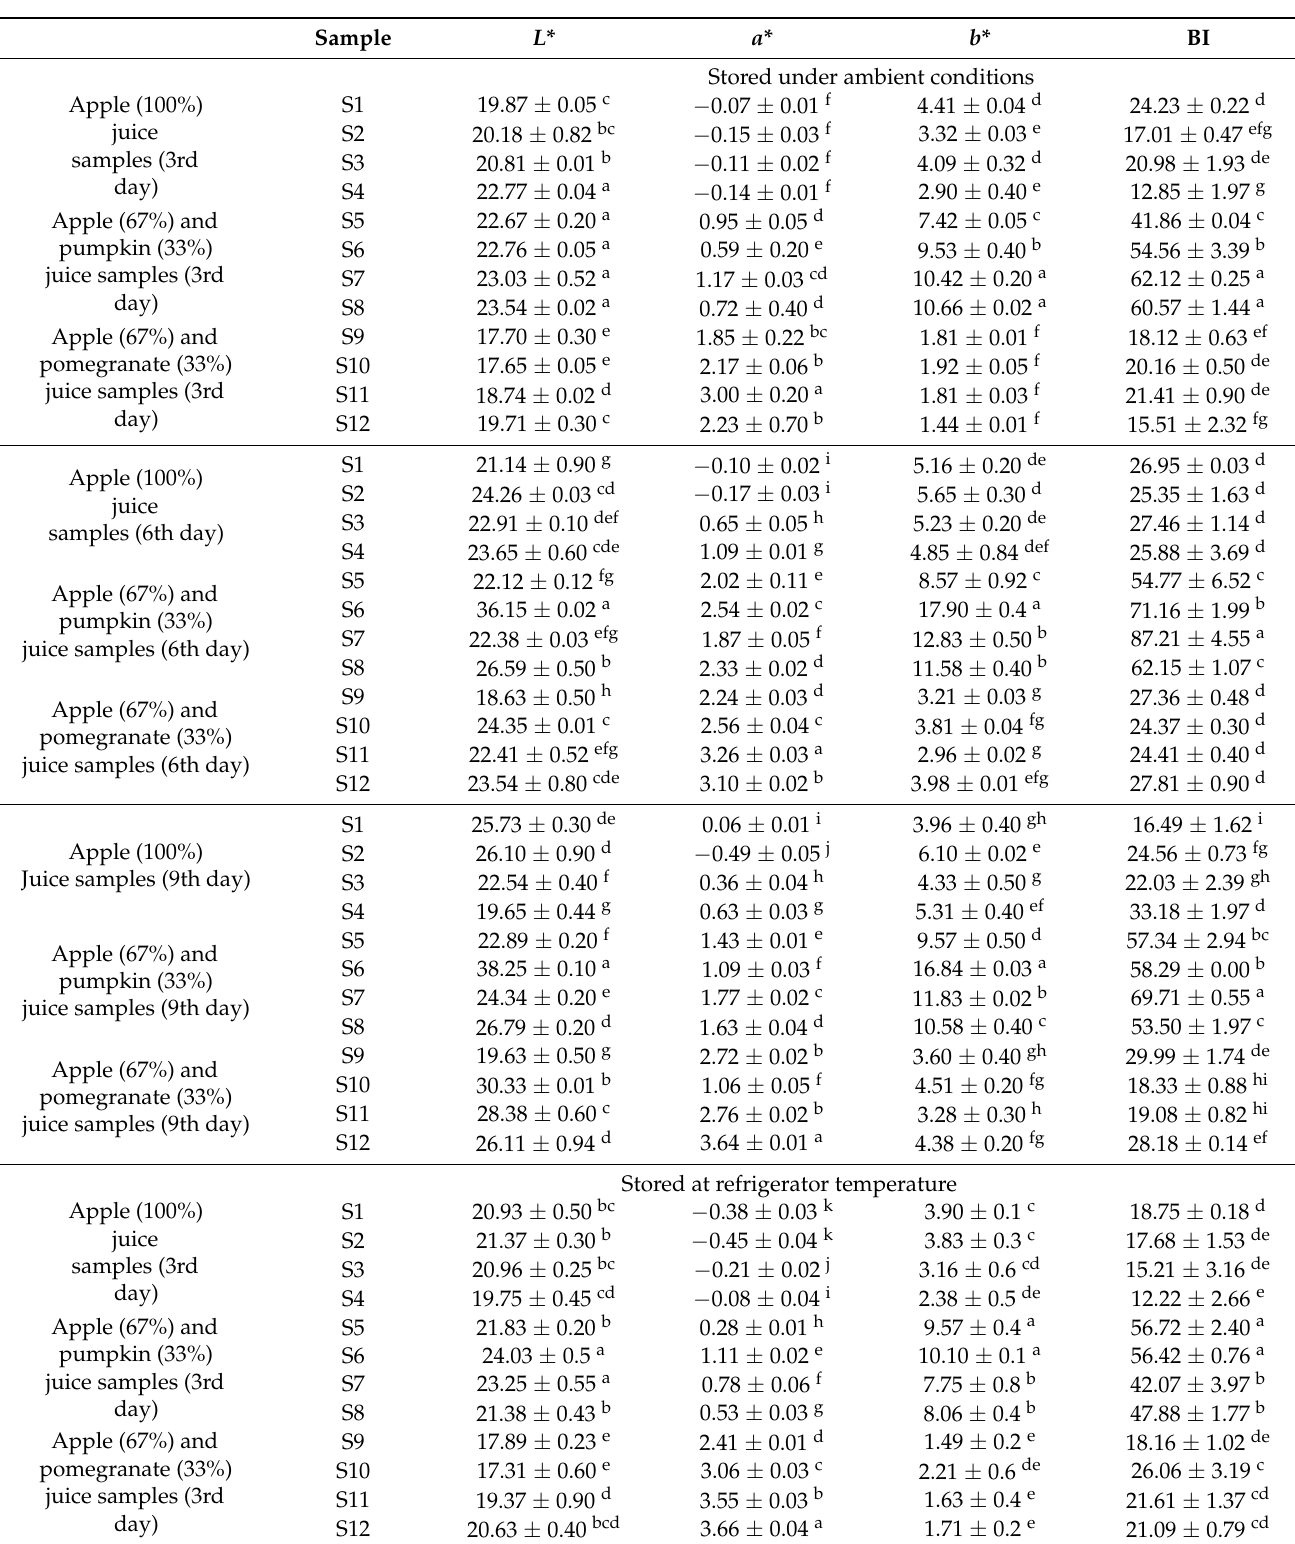
Table 5. Color parameters of juice samples during storage at room and refrigeration